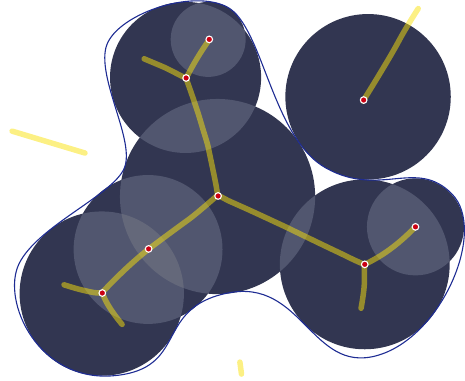
Figure 3. Some medial balls of a shape and in yellow the corresponding medial axis (Peters, 2018)